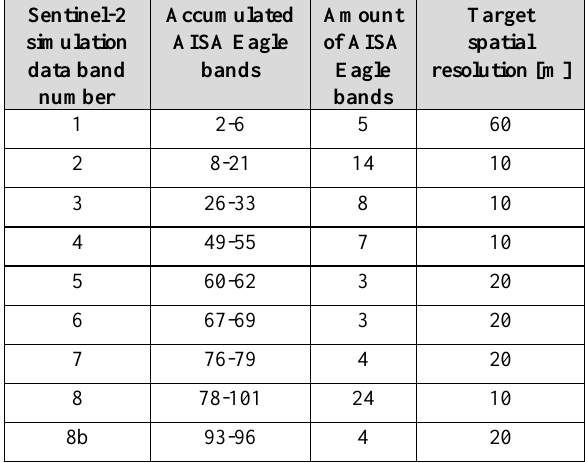
Table 4. Corresponding AISA Eagle bands for Sentinel-2 data simulation.